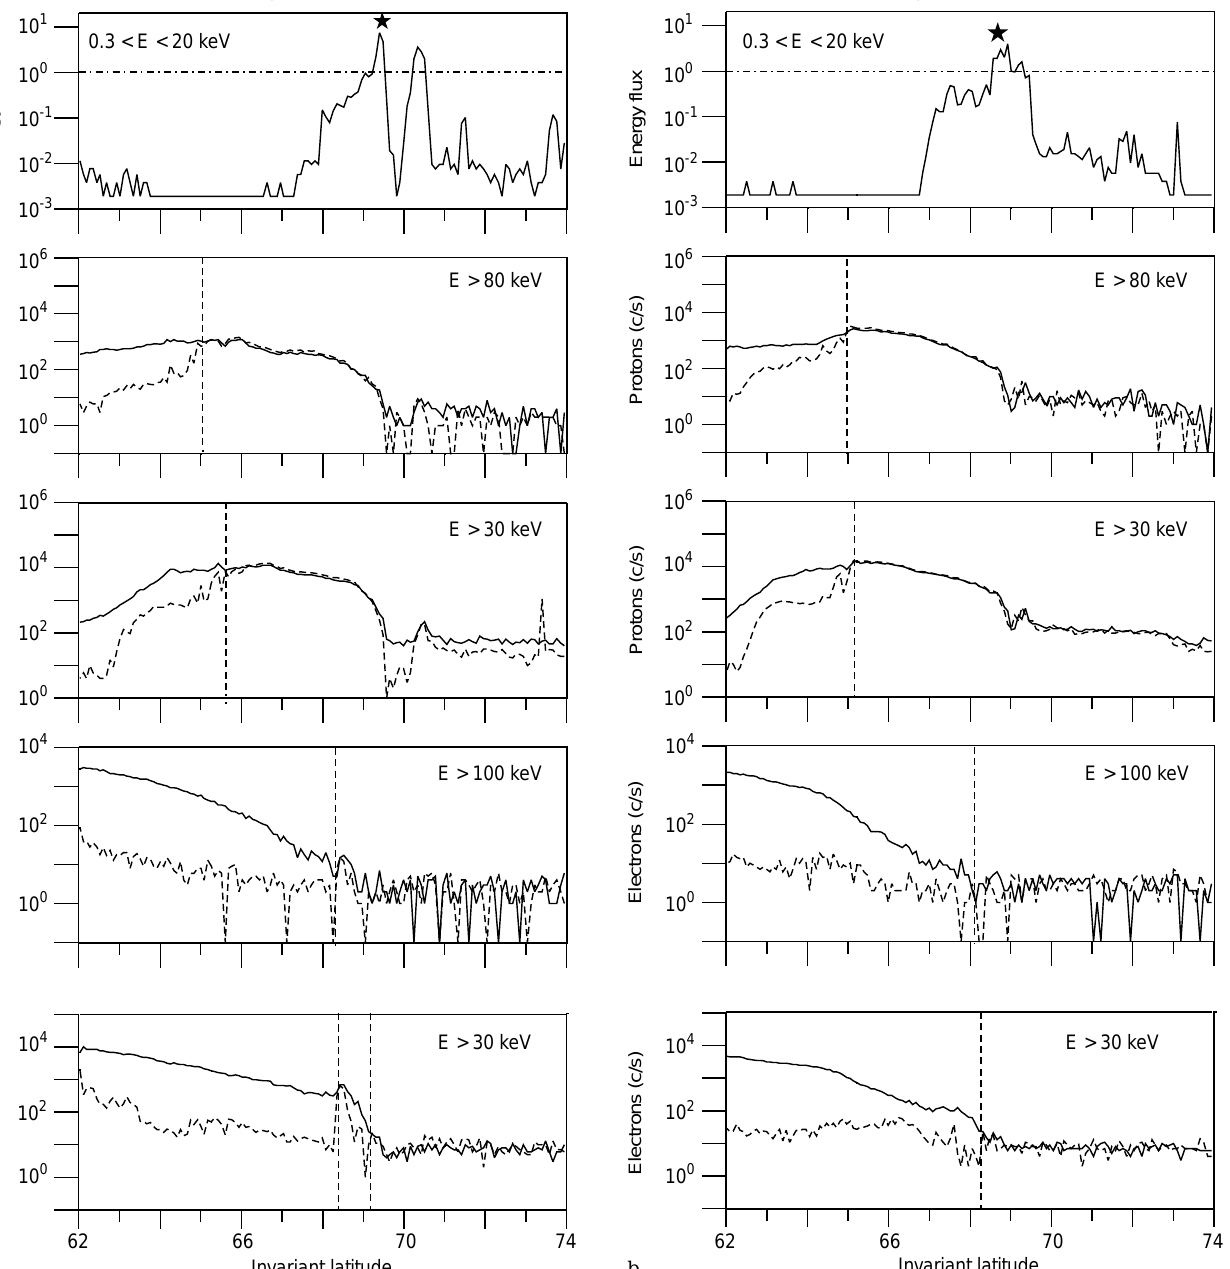
Fig. 1. a. (Event 1) Particle measurements on board the TIROS/ NOAA satellites made during the crossings of the aurora at 1816– 1820 UT of 27 August 1979. From top to bottom: the di(cid:128)erential flux of the 0 : 3 < E < 20 keV electrons measured by the TED instrument; count rates of the energetic protons with energies >80 and >30 keV, count rates of energetic electrons with energies >100 and >30 keV. For energetic particles both trapped ( solid line ) and precipitating ( dashed line ) fluxes are presented. Vertical dashed lines mark the isotropy boundaries for energetic particles. Horizontal dashed line at the top panel shows the energy flux level 1 ergs/cm 2 *s*sr. Asterisks mark the location of the discrete auroral arcs as observed by the all- sky cameras. (Note that in this case the double IB of the >30-keV electrons was observed, see text for explanation.) b (Event 2) Likewise